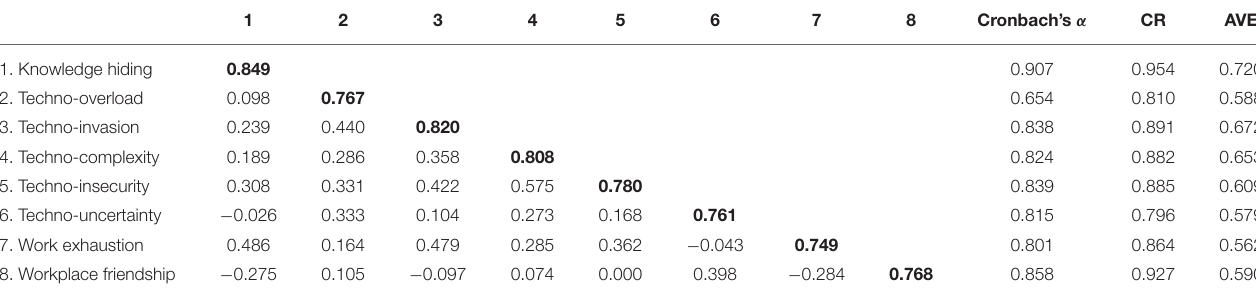
TABLE 4 | Reliability and convergent discriminant validity analysis ( N =